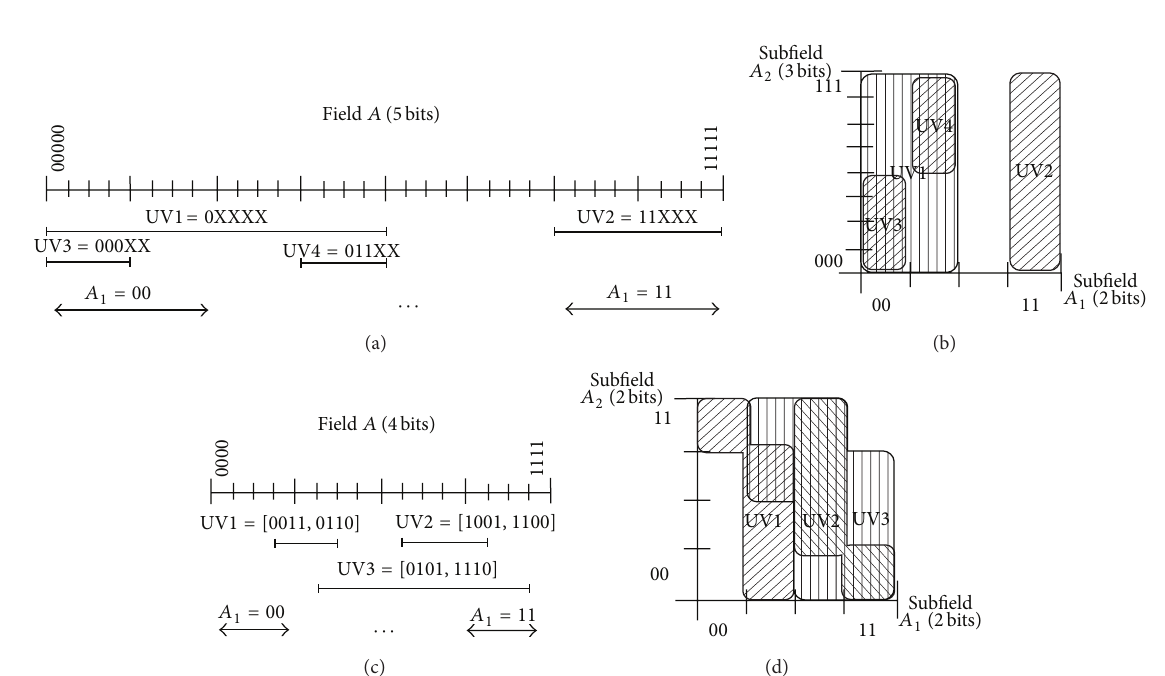
Figure 10: Effect of stitching: (a) prefix-based lookup example, (b) prefix stitching, (c) AR-based lookup, and (d) AR